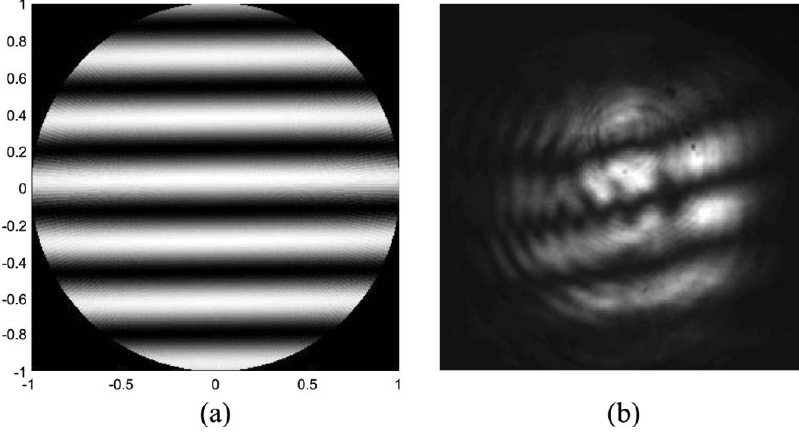
Figure 8. Interferogram results obtained from ( a ) numerical analysis and ( b )